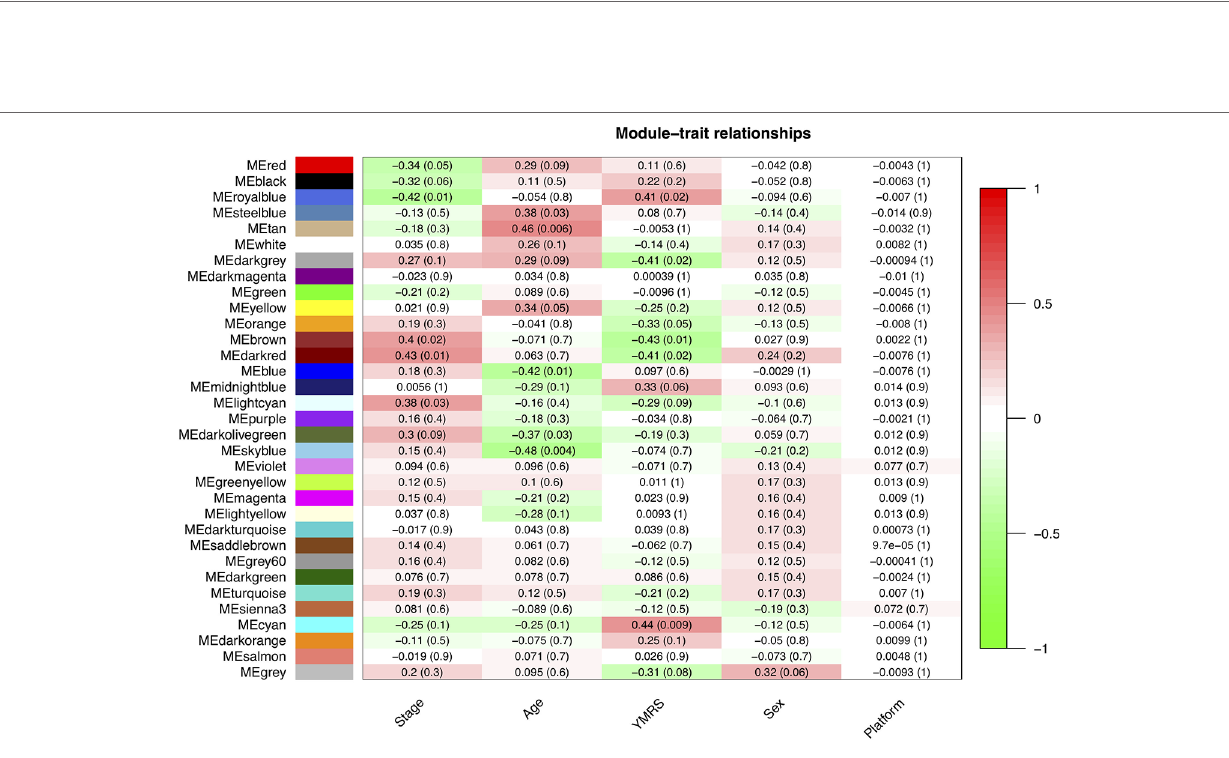
FIGURE 3 | The quantitative real-time PCR (qRT-PCR) results of overlapping DEGs. We chose five overlapping DEGs—MS4A14, PYHIN1, UTRN, DMXL2, and TAS2R5—for validation. All of these genes showed significant differences between manic and remission states with the same direction with original